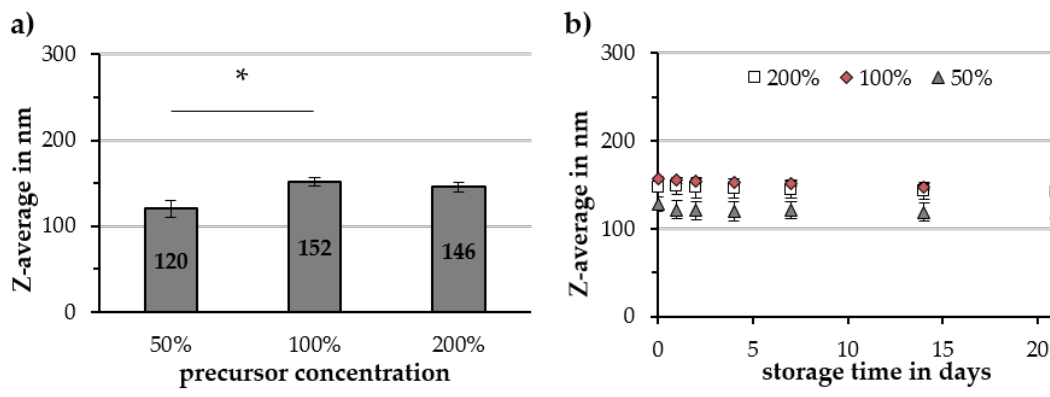
Figure A8. Influence of the precursor concentration (iron and gold) of Cit-Au-SPIONs on ( a ) the Z-average and ( b ) the particle stability during 21 days of storage in a fridge. Statistically significant changes are marked with * for p < 0.05. Table A2. Comparison of the parameters of Cit-Au-SPIONs with varied precursor concentrations. Precursor Z-Avg. Concentration